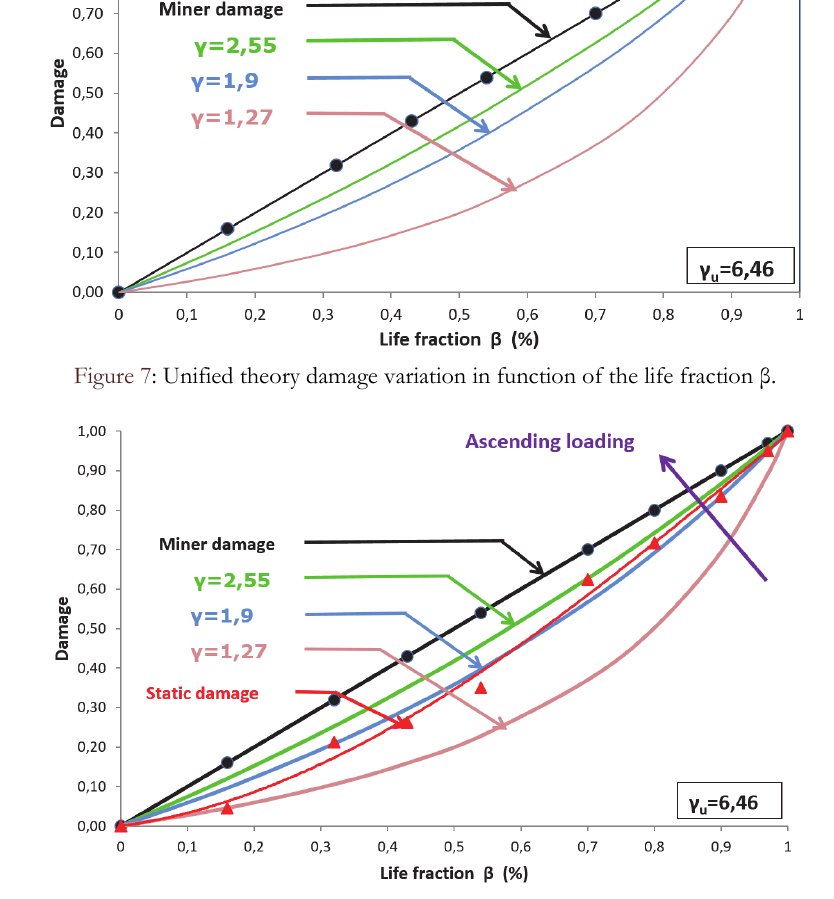
Figure 8: Experimental, unified and Miner damages